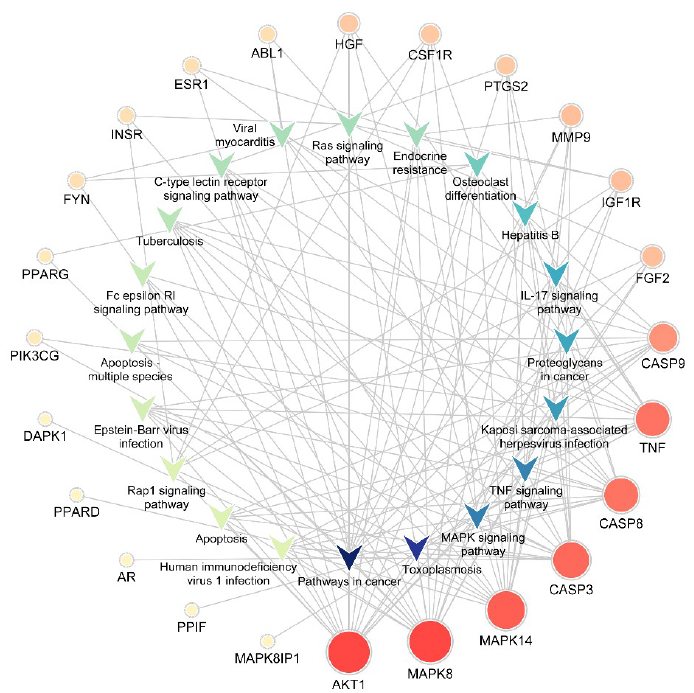
Figure 3. Target-pathway network. The V-shaped patterns represent pathways, and the circles represent targets. The sizes of the circles represent the degree of importance in the pathway. IL, Interleukin.